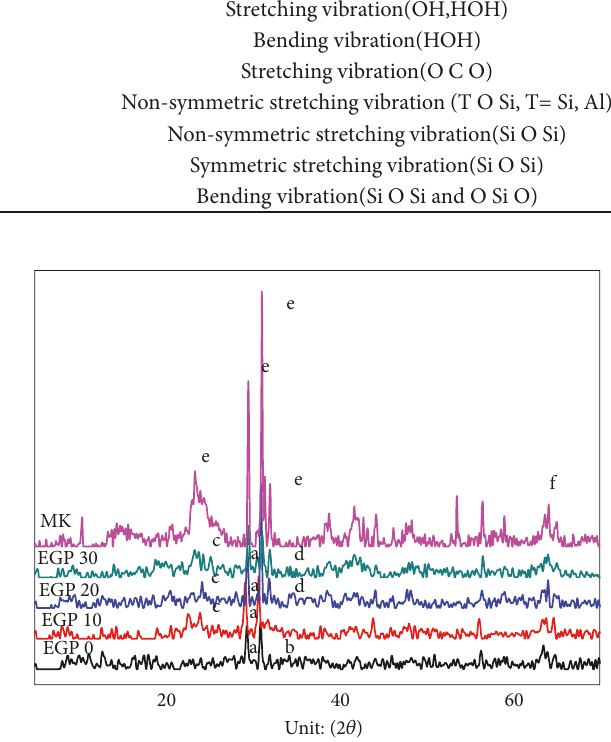
Figure 1: Compressive strength of different resin content in curing for 1d, 3d, and 28d.